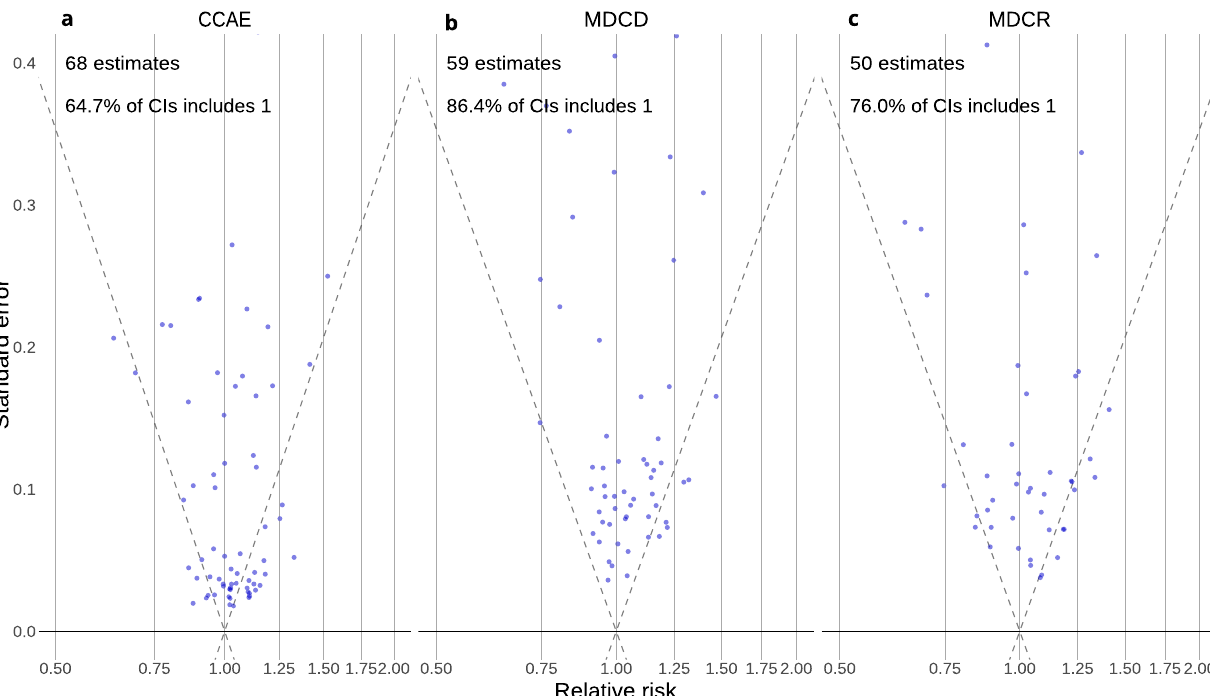
Fig. 4 Systematic error. Effect size estimates for the negative controls (true hazard ratio = 1) in a CCAE, b MDCD, and c MDCR databases. Estimates below the diagonal dashed lines are statistically signi fi cant (different from the true effect size; alpha = 0.05). A well-calibrated estimator should include the true effect size within the 95% con fi dence interval, 95% of times.